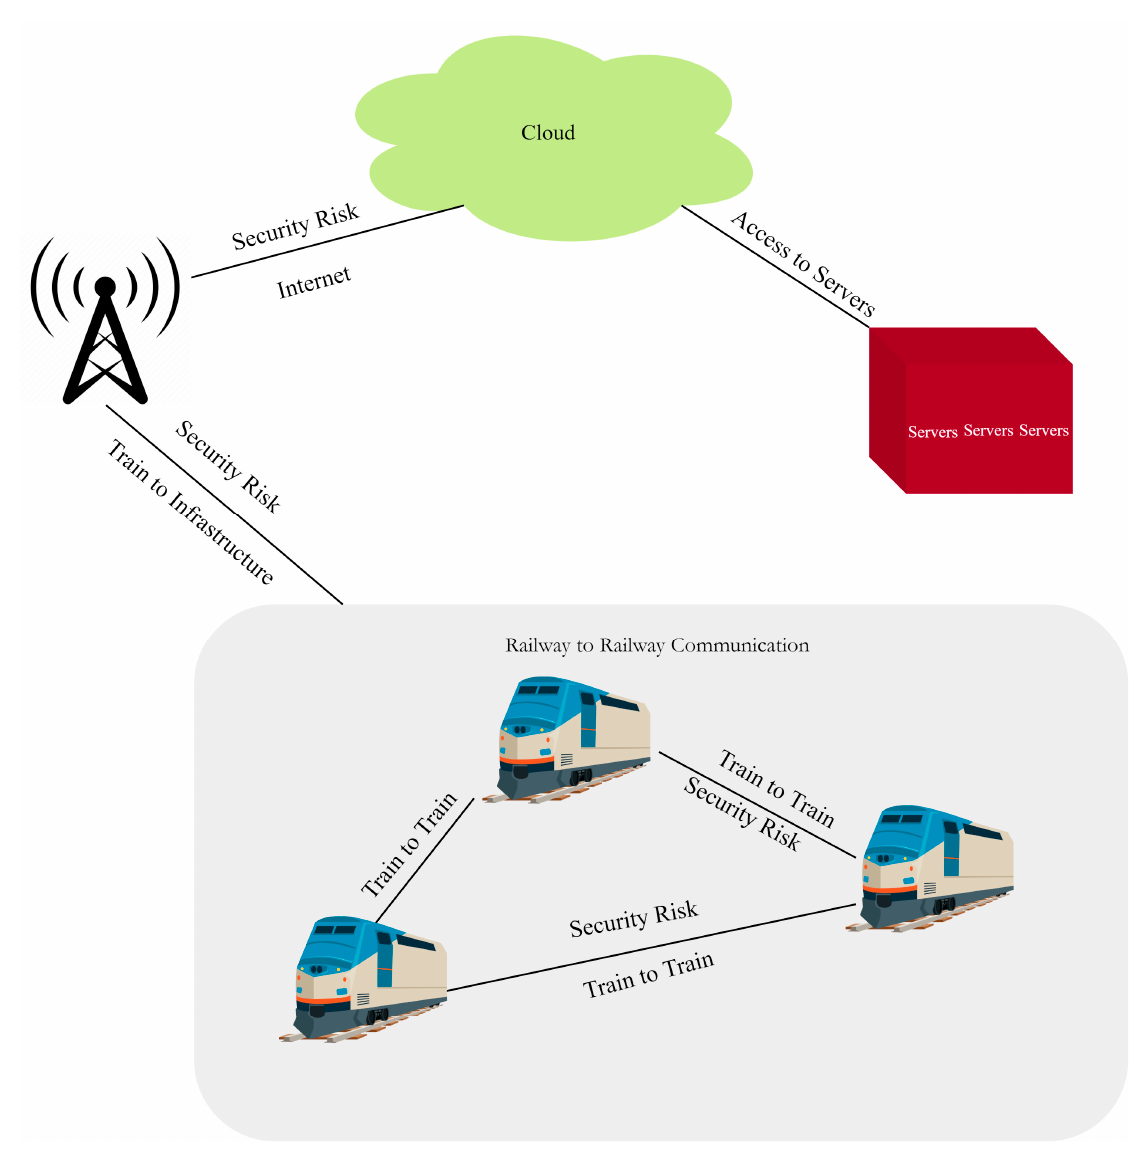
Figure 2. Possible Security Risks in Internet of Railways Scenario.